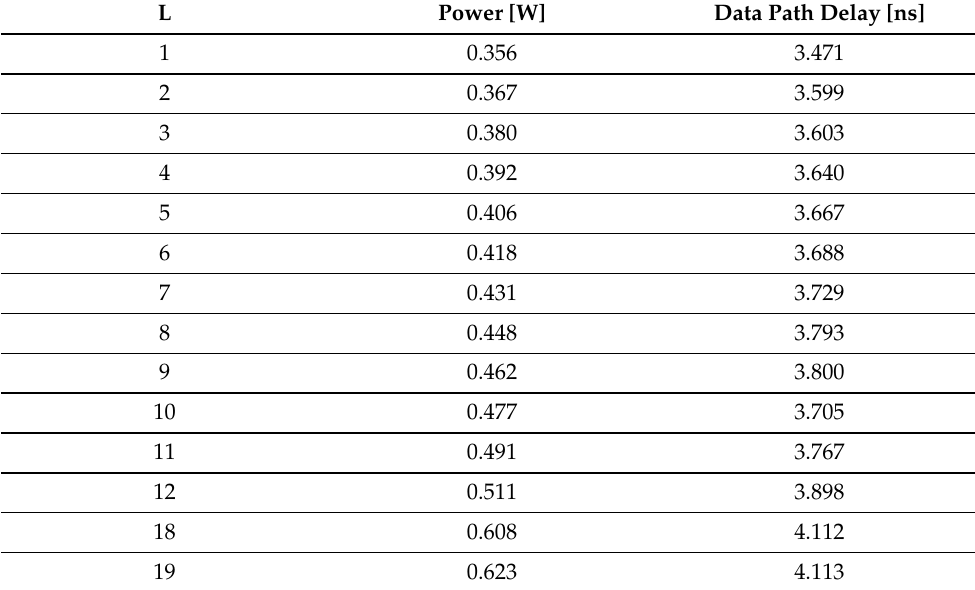
Table 10. Influence of input register on cycle time and consumed